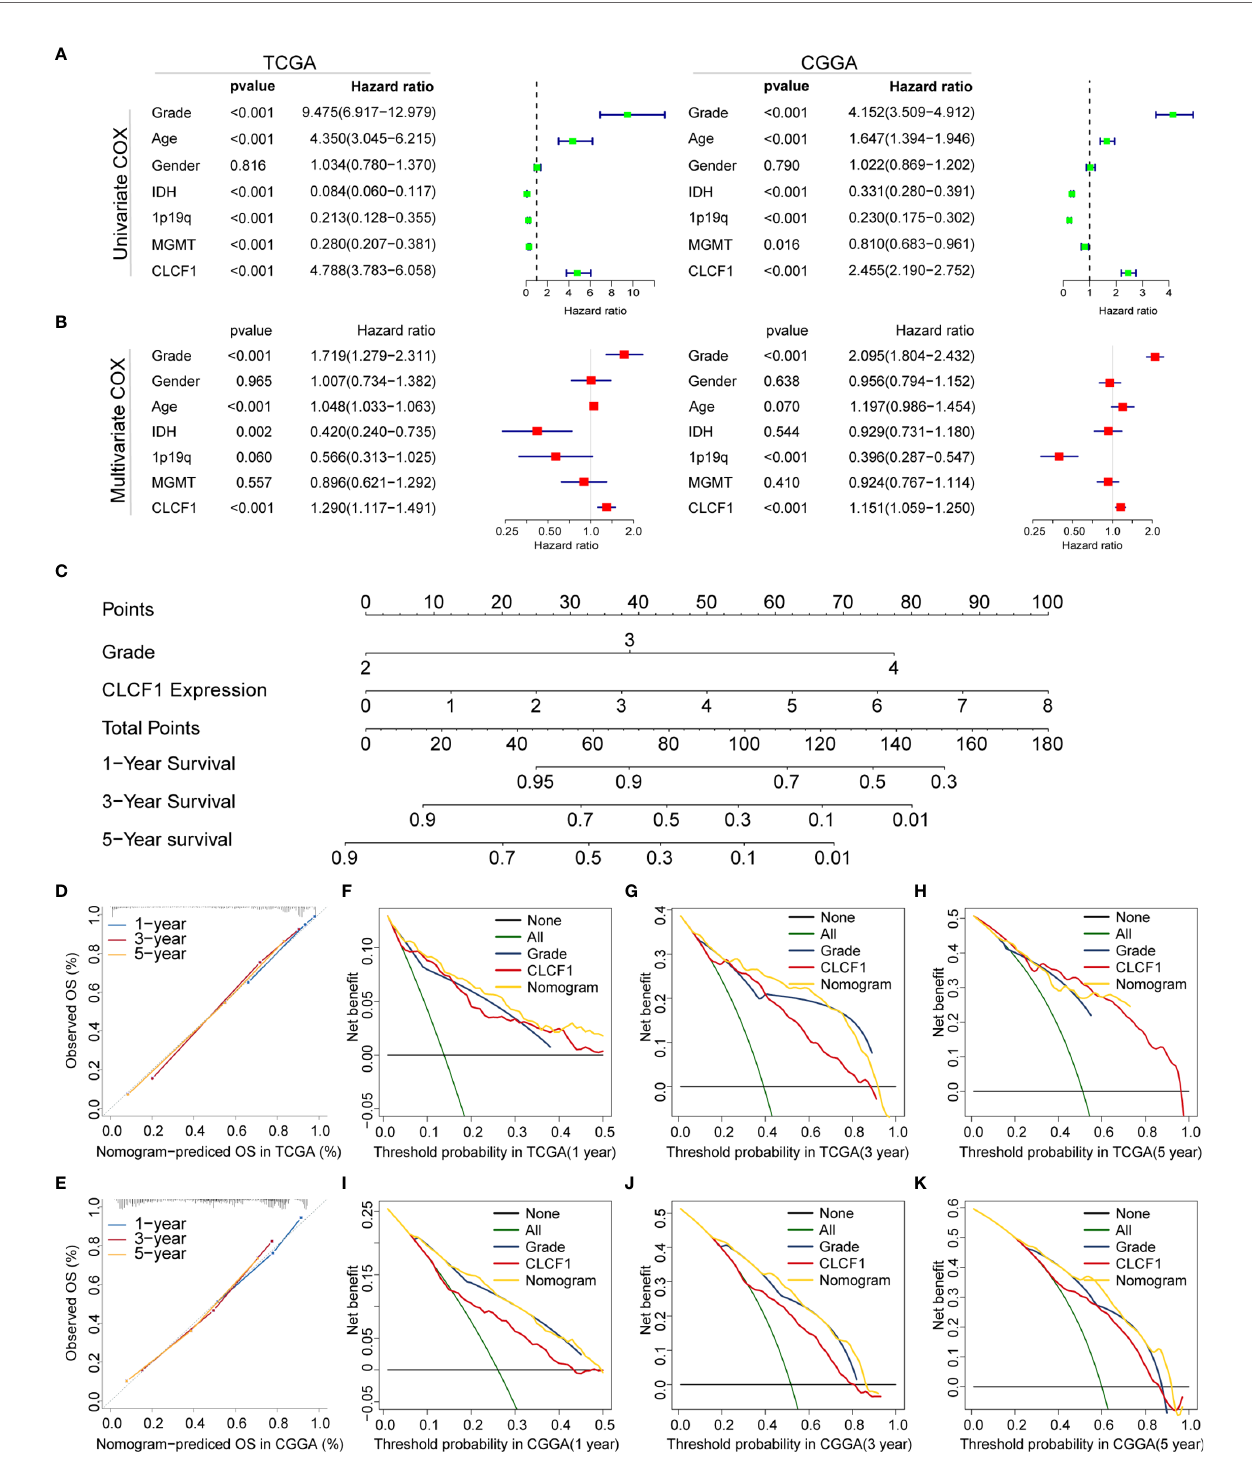
FIGURE 4 | Univariate and multivariate Cox analysis of clinicopathological characteristics and CLCF1 expression in (A) TCGA cohort and (B) CGGA cohorts; Nomogram constructed with WHO grade and CLCF1 expression in (C) TCGA cohort; (D, E) The calibration plots: verify the accuracy of the predicted 1-, 3- and 5- OS in the nomogram; and (F – K) DCA curves: CLCF1 and Grade curves represent its own prognostic value, Nomogram curve represents the synthetical prognostic value of CLCF1 and Grade, None curve represents no prognostic value and All curve represents the theoretical best prognostic